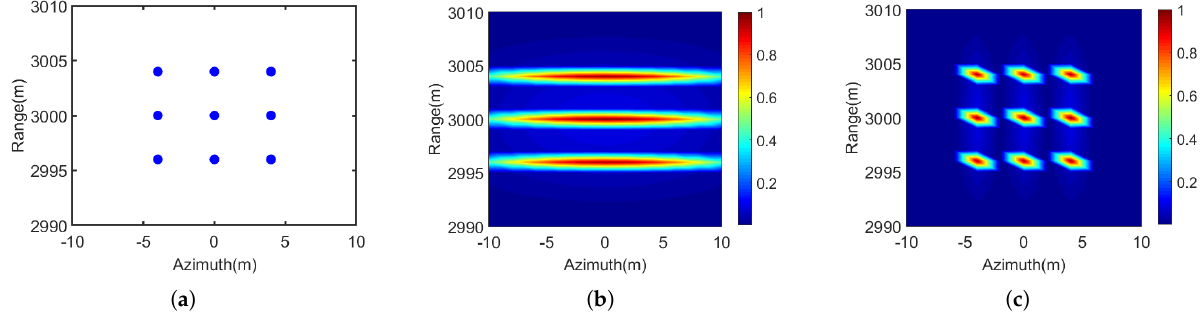
Figure 4. ( a ) Nine-point target distribution: ( b ) BP imaging result; ( c ) CS imaging